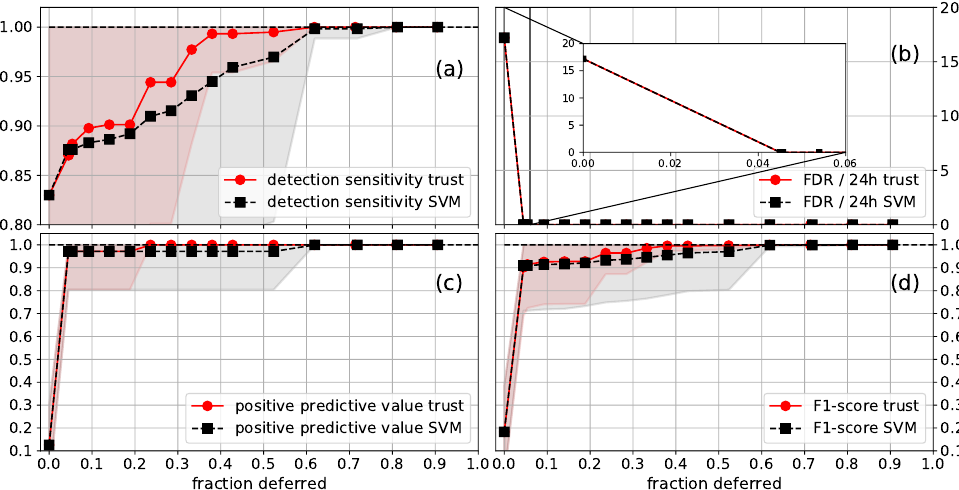
Figure 8. Average ( a ) detection sensitivity; ( b ) FDR/24h; ( c ) PPV; ( d ) F1-score as a function of the fraction of the data that was deferred to a human annotator, for the FS SVM ( p low = 5). The standard deviation of the performance is shown as a shaded area, with the upper values being capped at one. Segments were deferred using the SVM confidences (SVM) or trust scores (trust) from a trust model trained on the FS labels. The first point with a deferred fraction of larger than zero is the performance when all segments that contain a seizure flag are deferred. The inset plotted in the FDR figure shows that around 4.5% of the EEG data were contained in segments that contained seizure